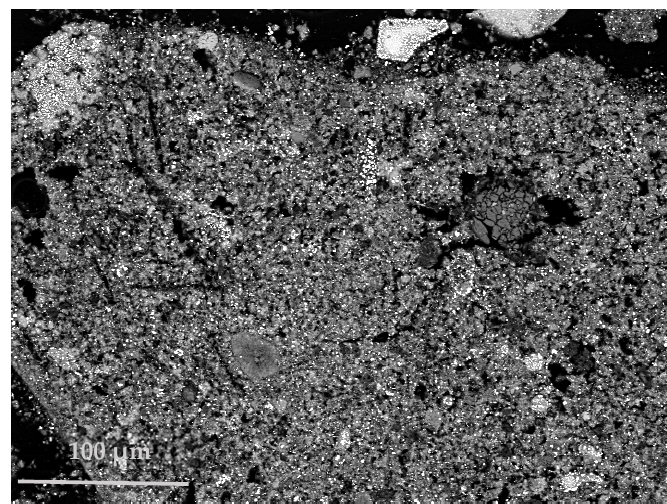
Figure 5. SEM—BSE image of the solid residue after water leaching of the thermal product (roasting BR and NaOH at 600 °C, under H 2 gas). The bright areas are the Fe rich phase, of which the particles vary in size and are spread in the matrix.